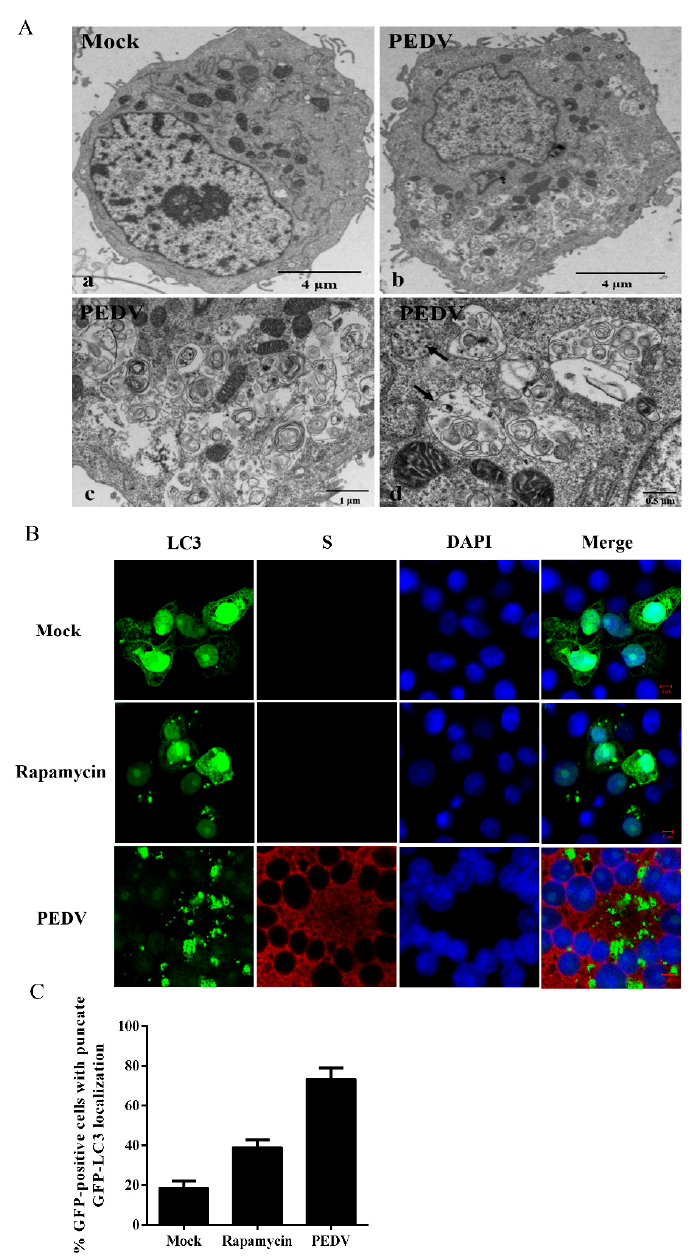
Figure 1. Porcine epidemic diarrhea virus (PEDV) infection increases the formation of autophagosome-like vesicles. ( A ) TEM observation. Vero cells were mock-treated ( a ) or infected with PEDV at 0.1 MOI for 24 h ( b ). Scale bar, 4 µ m ( a , b ). ( c ) higher-magnification views of ( b ). Scale bar, 1 µ m. ( d ) enlargement of the autophagosome-like structure. Scale bar, 0.5 µ m. ( B ) Confocal microscope. The redistribution of GFP-LC3 was induced by PEDV infection. Vero cells were transfected with the plasmid GFP-LC3. Twenty-four hours later, the transfected cells were infected or mock-infected with PEDV at 0.1 MOI for 18 h. Meanwhile, cells pretreated with rapamycin for 4 h served as a positive control. PEDV infection was detected with the monoclonal antibody against PEDV S and cell nuclei were counterstained with 4',6-diamidino-2-phenylindole (DAPI). Scale bar, 5 µ m. ( C ) The relative number of cells with punctate GFP-LC3 locations relative to all green fluorescent protein-positive cells. The data were presented as mean ± SEM of three independent